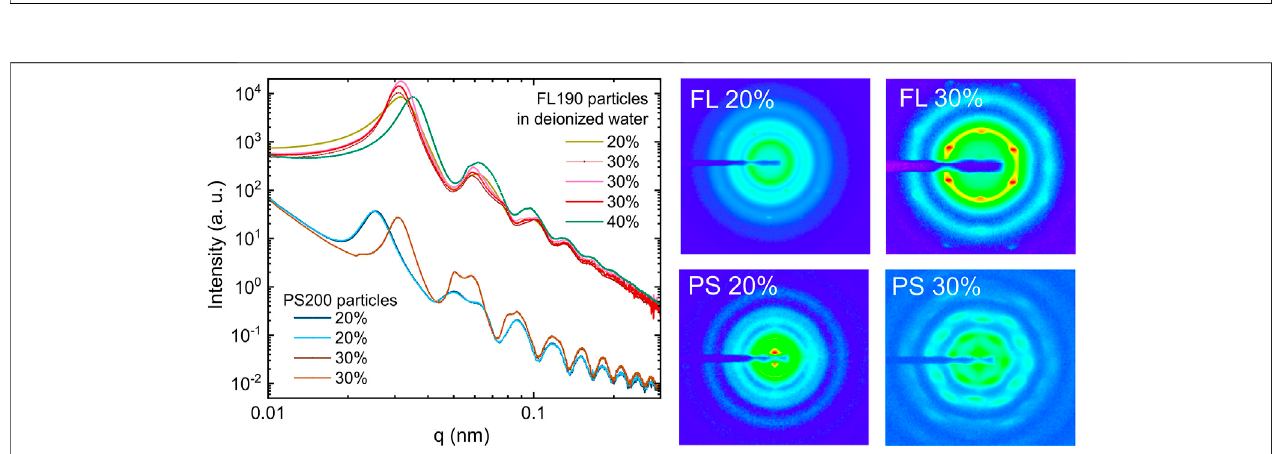
FIGURE6| TwodimensionalSAXSspectraandthecorresponding, radiallyintegratedscatteringintensitiesfordifferentvolume fractionsofFL190 particlesand for PS200 particles in deionized water.